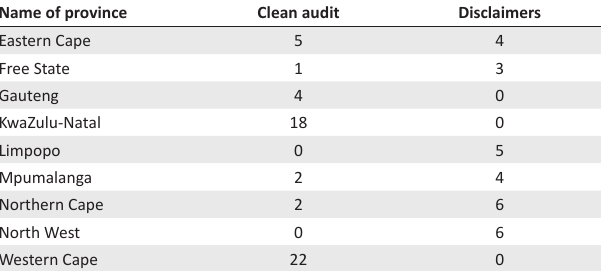
TABLE 3: Clean audits and persistent disclaimers per province (2014–2015 financial